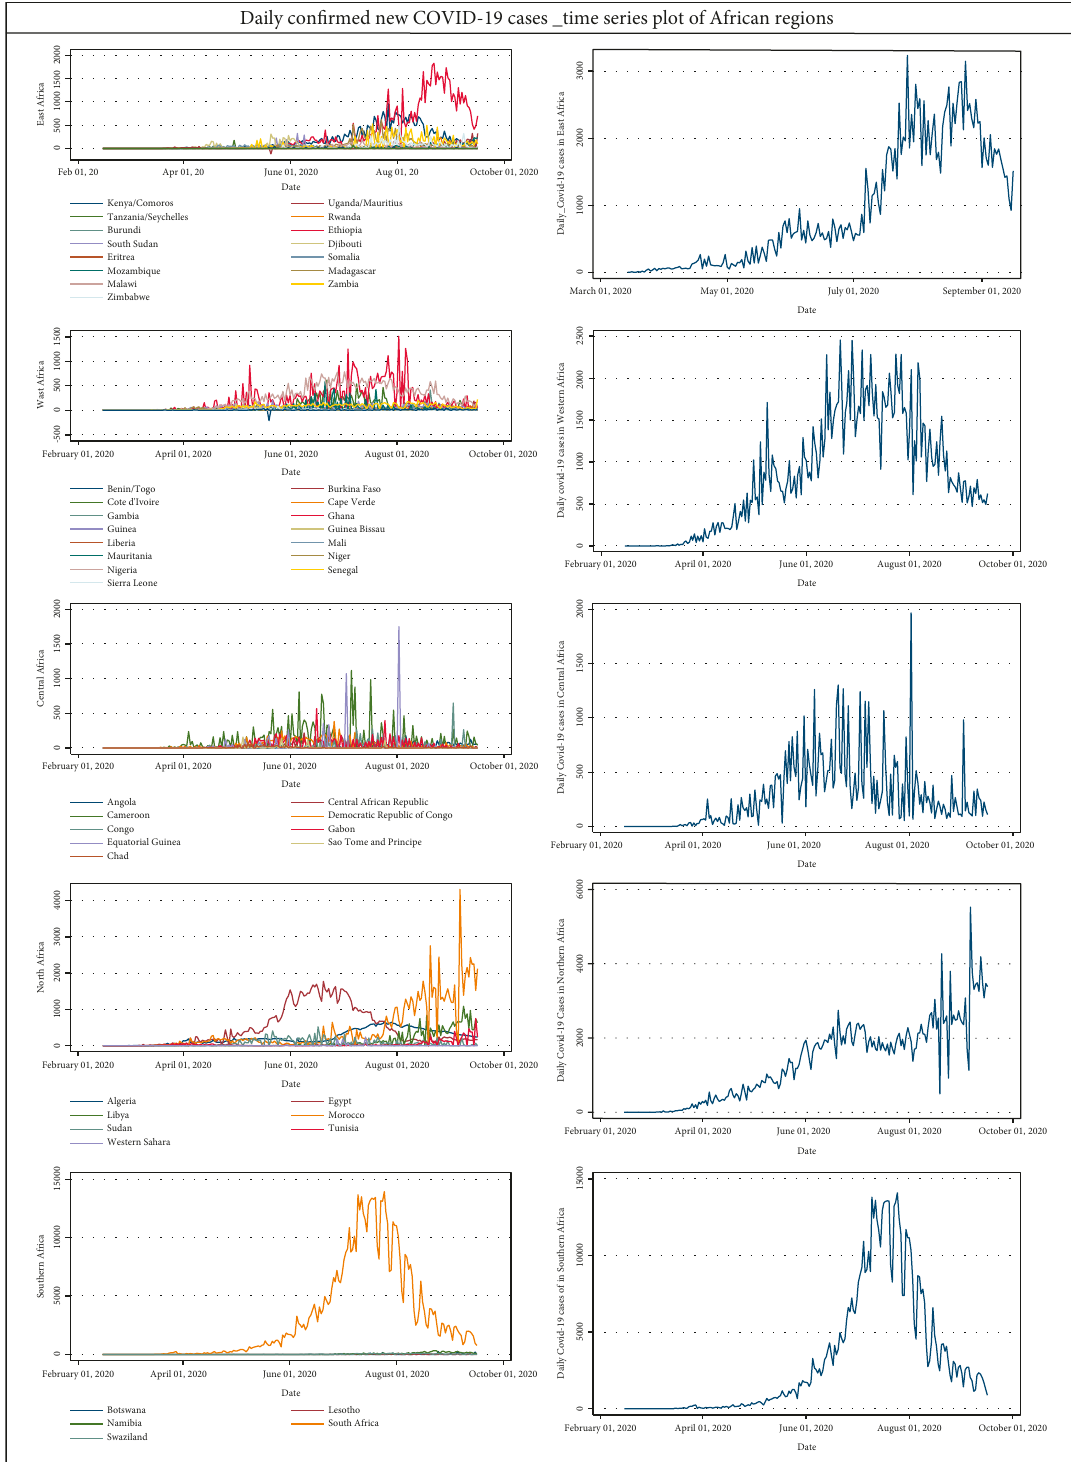
Figure 1: COVID-19 daily new cases time series plots of African countries and African trend. If we include the third component, which is integrated When a variable Y is not stationary, a common solution t into our ARMA model, it will become ARIMA. is to use a differenced variable: Δ Y t � Y t − Y t − , for first- 1 order differences, and by differencing (integrating ( I )) the original series before using them will remove any linear time